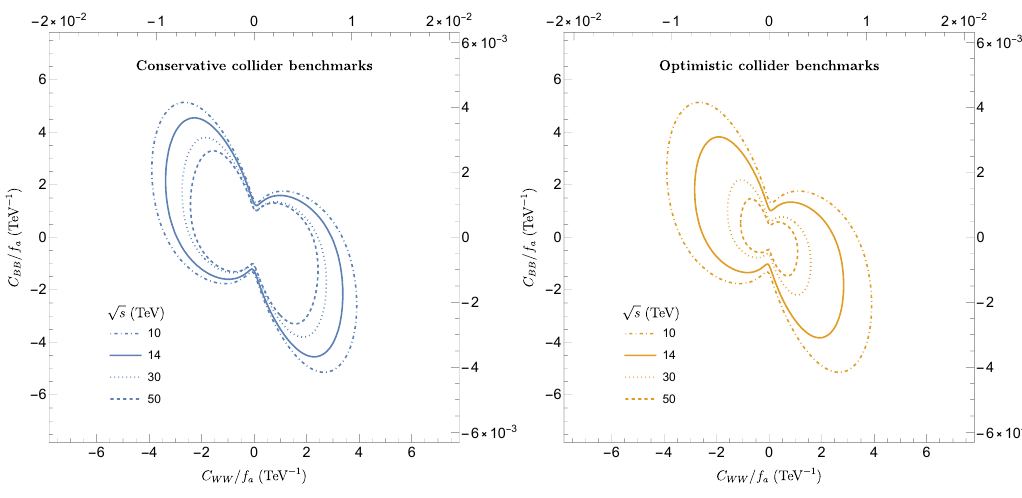
Figure 12 . Projected 2 σ constraint contours in the C BB /f a − C WW /f a plane for different muon collider running benchmarks, assuming C BW = 0 . Left : L con scenario. Right : L opt scenario.